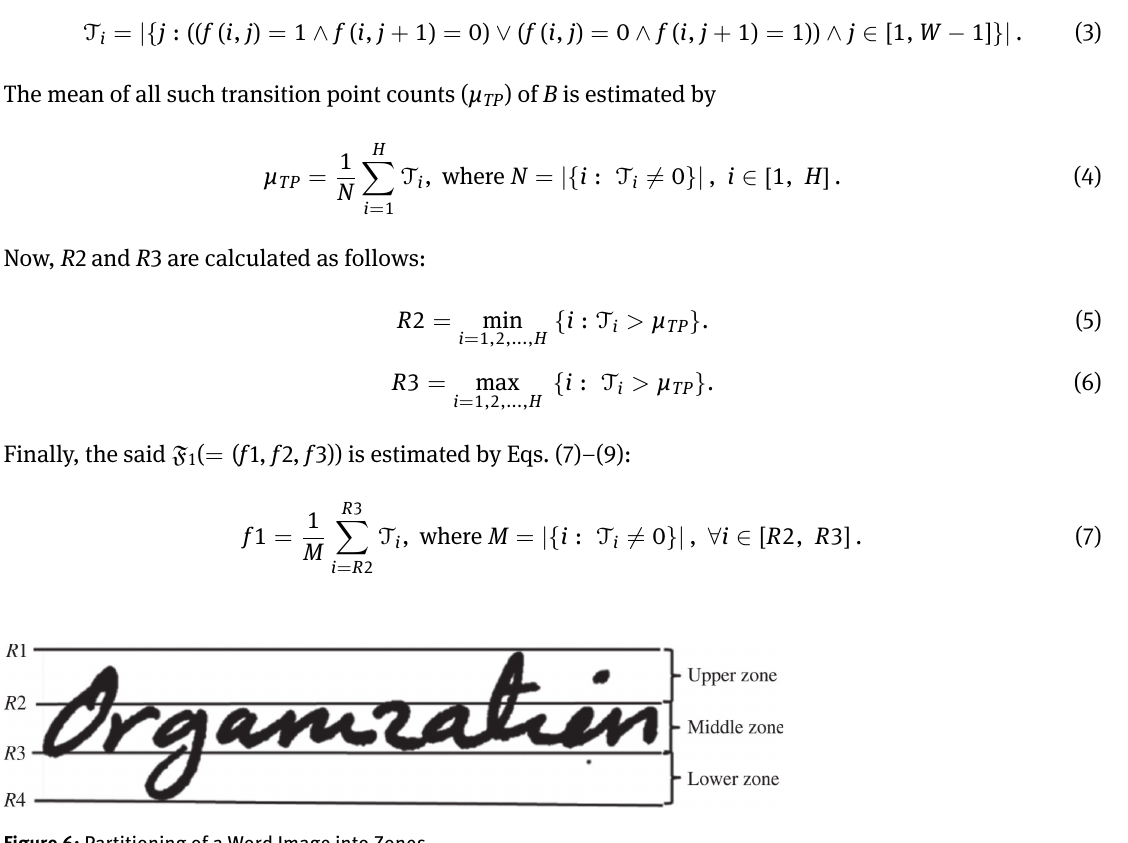
Figure 6: Partitioning of a Word Image into